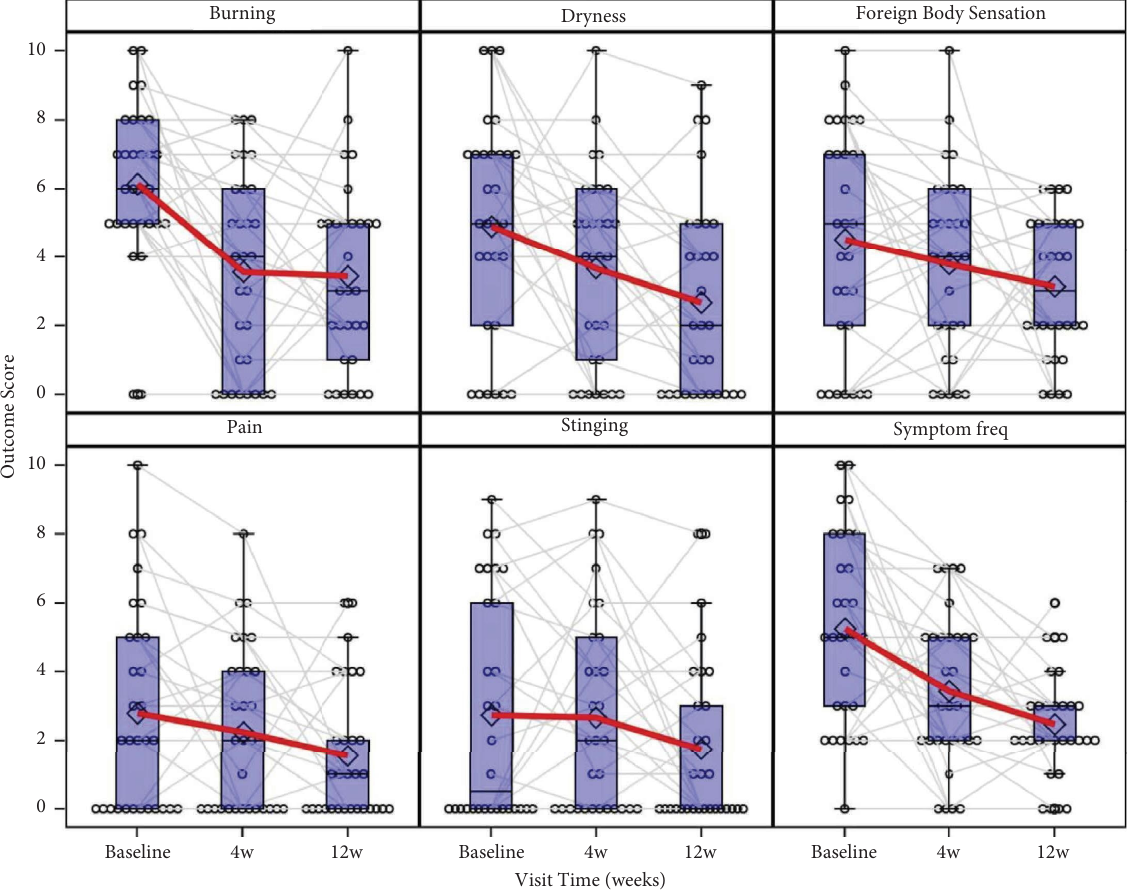
Figure 1: Primary outcomes scores by time with individual